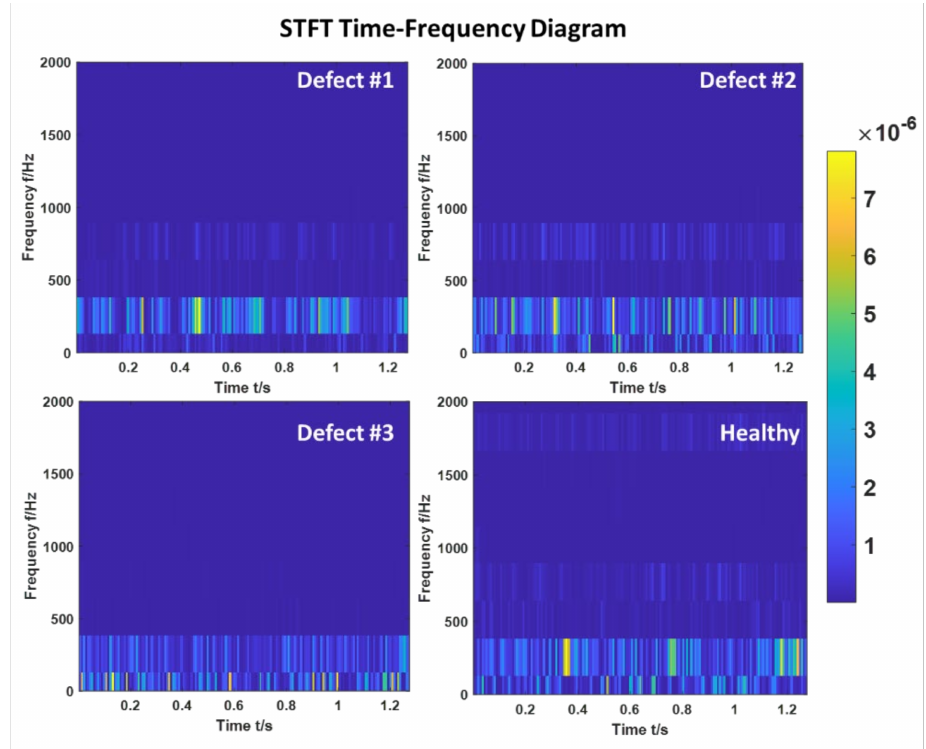
Figure 5. Spectrogram images of the vibration data as the input into the 2D